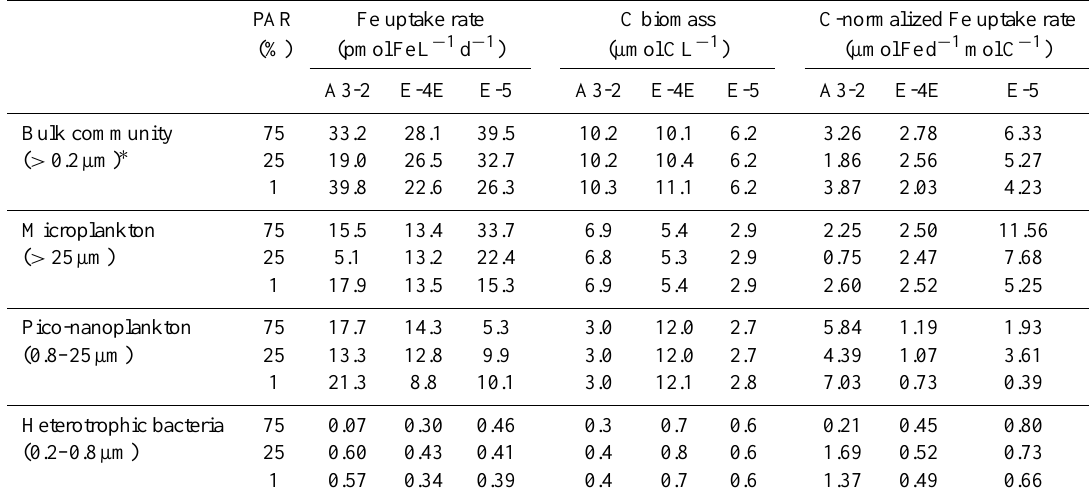
Table 3. Iron uptake rates ( ρ Fe), carbon biomass (POC), and C-normalized Fe uptake rates ( ρ Fe:POC) of the bulk community and the three size fractions for incubations conducted at 75, 25 and 1% of the photosynthetically active radiation (PAR, % of surface PAR) on unfiltered seawater (see text and Fig. 2a for details).